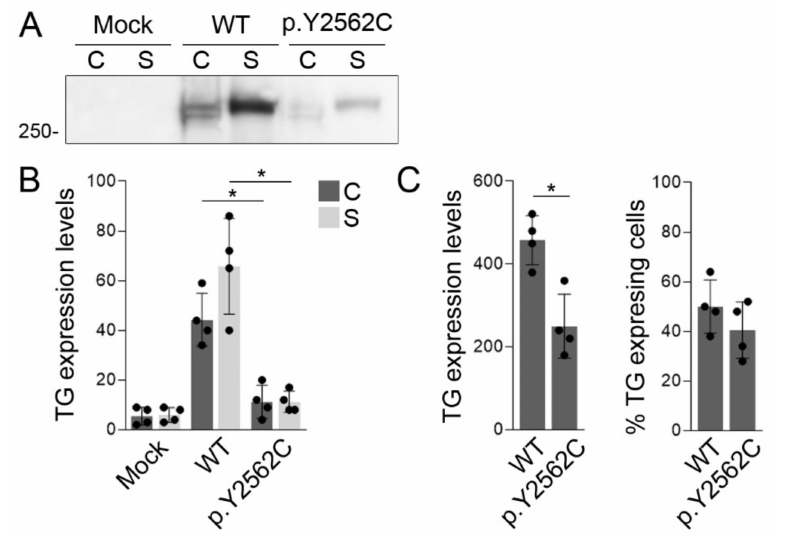
Figure 3. The variant p.Y2563C reduces the secretion of TG polypeptides. ( A ) Representative western blot analysis of TG expression in serum-free supernatants (S) and cell lysates (C) of HEK-293T cells transiently transfected with an empty expression vector (Mock) or expression vectors encoding full-length mouse TG or p.Y2562C TG. Monomers of TG were resolved as a single band of a molecular mass corresponding to ~330 kDa. ( B ) Densitometric analysis of TG expression levels in cell lysates (C) and supernatants (S). Data are expressed as relative units calculated based on the background- subtracted mean intensity of WT or p.Y2562C TG bands ± SD (n = 4). * p < 0.05 vs. WT TG-expressing cells (ANOVA, Holm-Sidak tests). ( C ) Flow cytometry analysis to assess transfection efficiency and TG expression levels in permeabilized HEK-293T cells transiently expressing WT or p.Y2562C TG. The TG expression levels are expressed as median fluorescence intensity (MFI) ± SD (n = 4). * p < 0.05